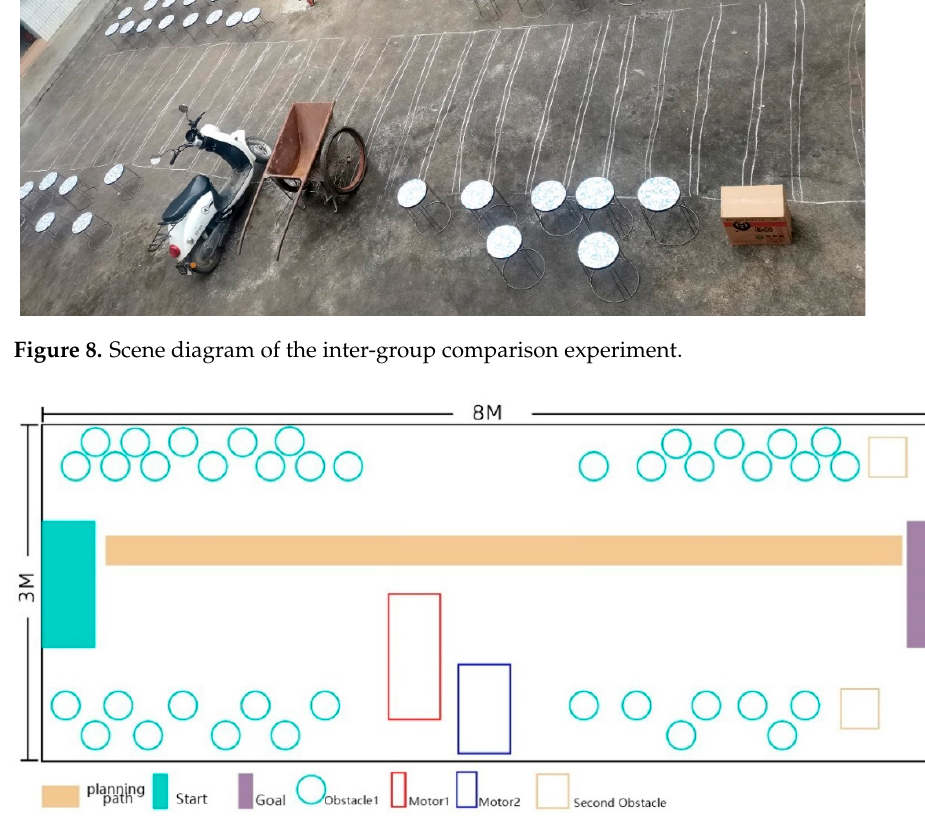
Figure 8. Scene diagram of the inter-group comparison experiment.